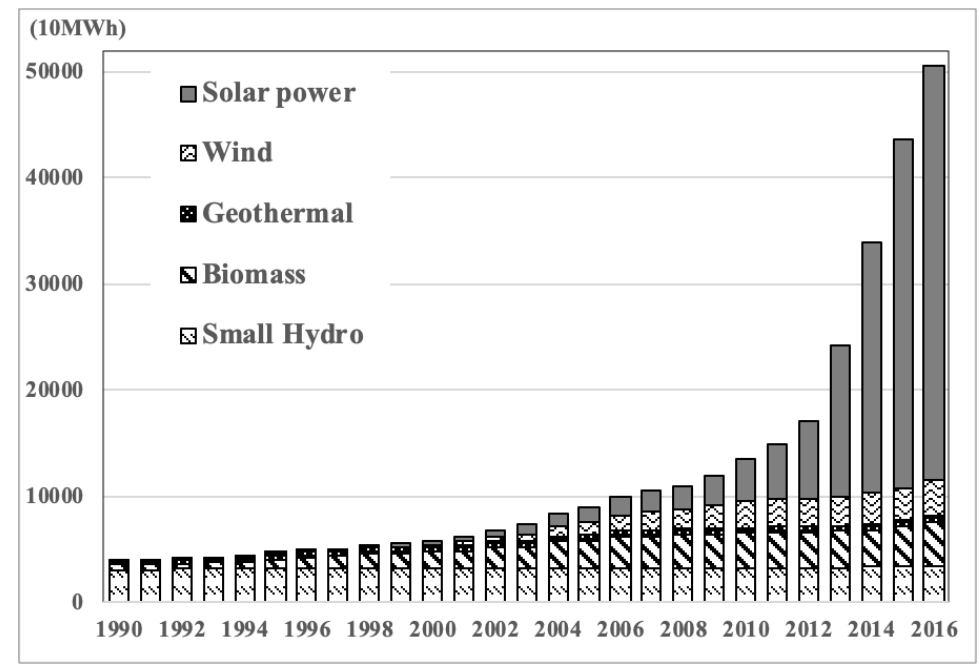
Figure 2. Trend in renewable energy cumulative capacity in Japan (source: ISEP, 2017 [38]).